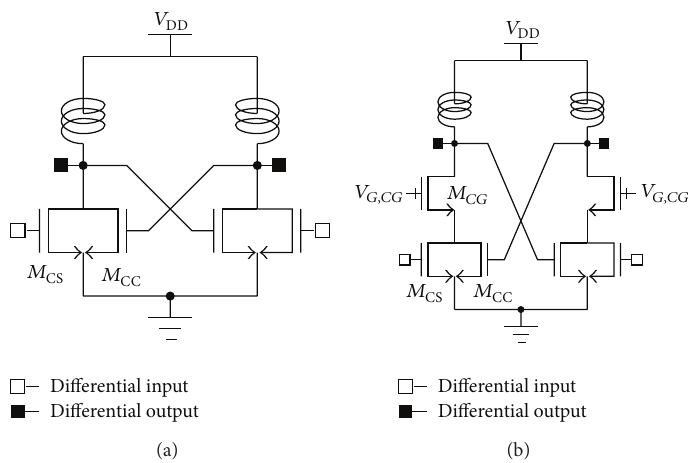
Figure 1: CMOS power amplifiers using mode-locking technique: (a) typical and (b) modified structures.